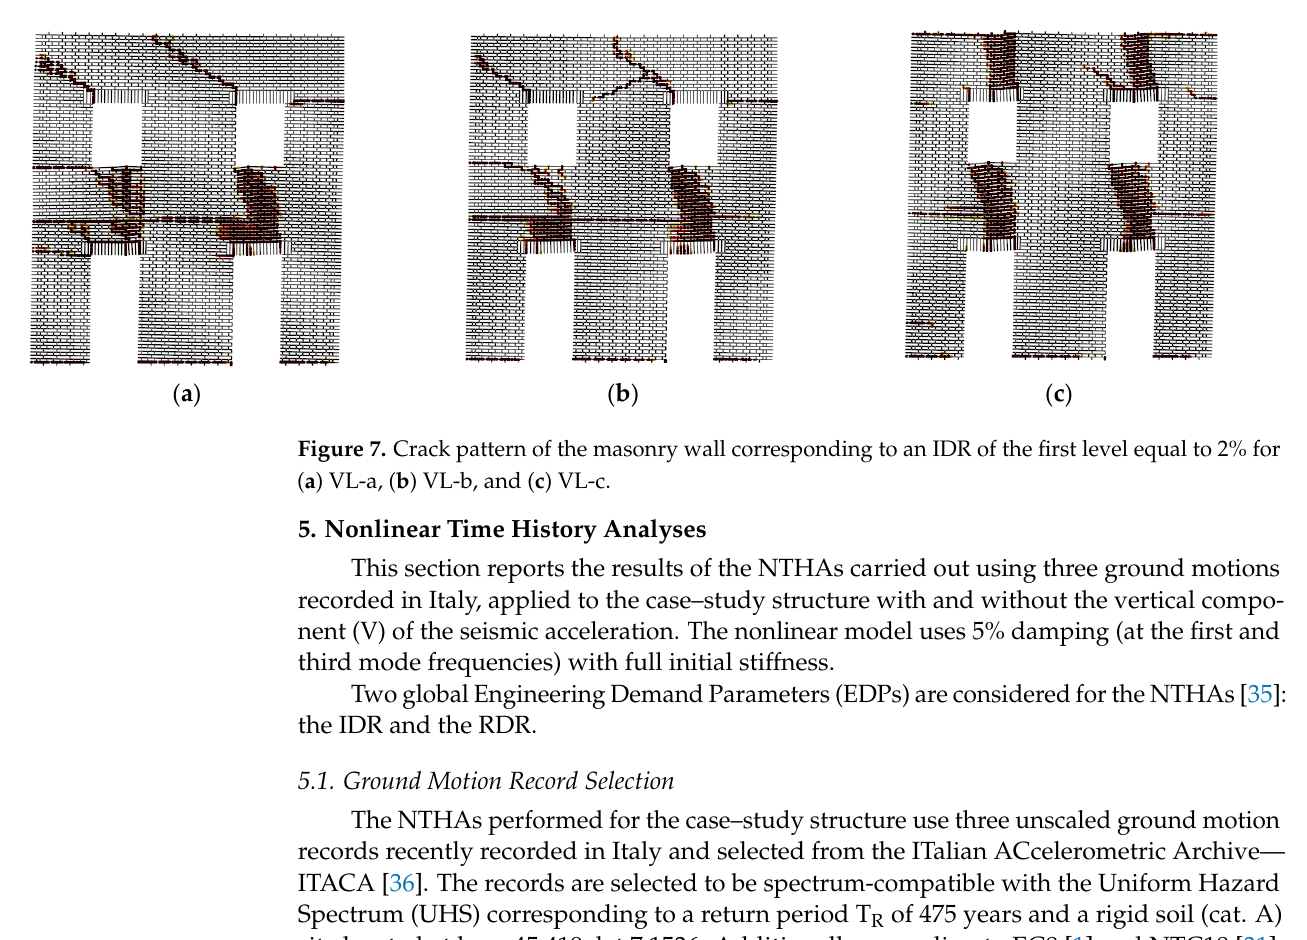
Table 4. Ground motion records.